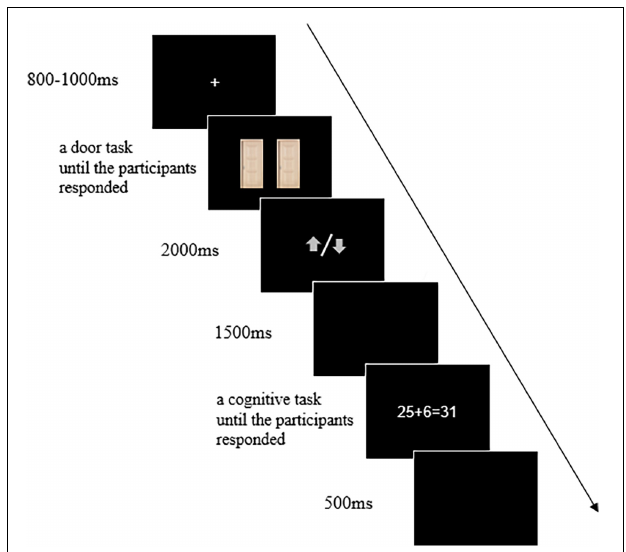
FIGURE 1 | The example for procedure of a trial. Participants selected the left or right door by clicking on the left or right mouse button based on their expectations for the reward, after receiving the feedback performed the cognitive task to judge the correctness of the math equation.